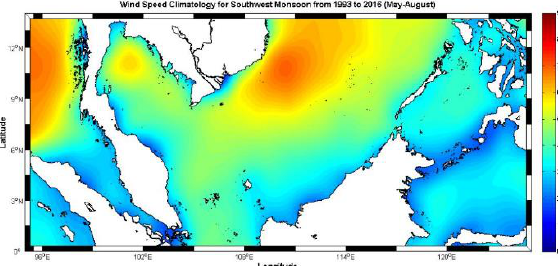
Figure 9. Average of wind speed during Southwest